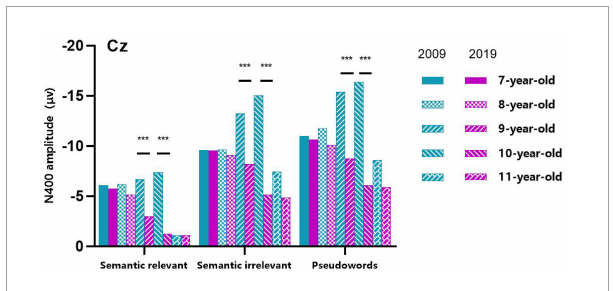
FIGURE3 Comparison of N400 amplitude of children aged 7–11 years across 10 years. N400 amplitude of children aged 9 and 10 years in 2009 was significantly larger than that of the same age group in 2019. The symbol “***” represents p <